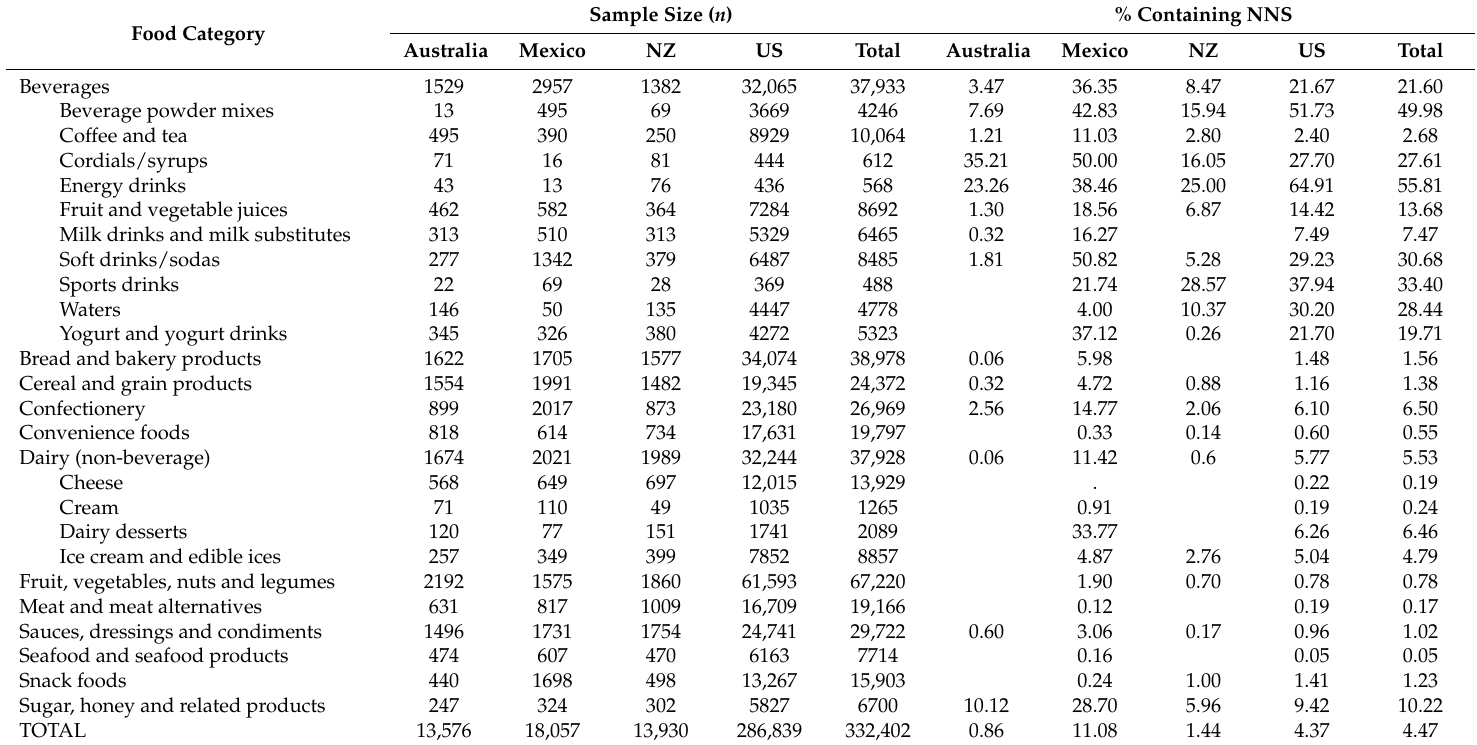
Table 1. Sample size and percentage of products containing non-nutritive sweeteners (NNS) by